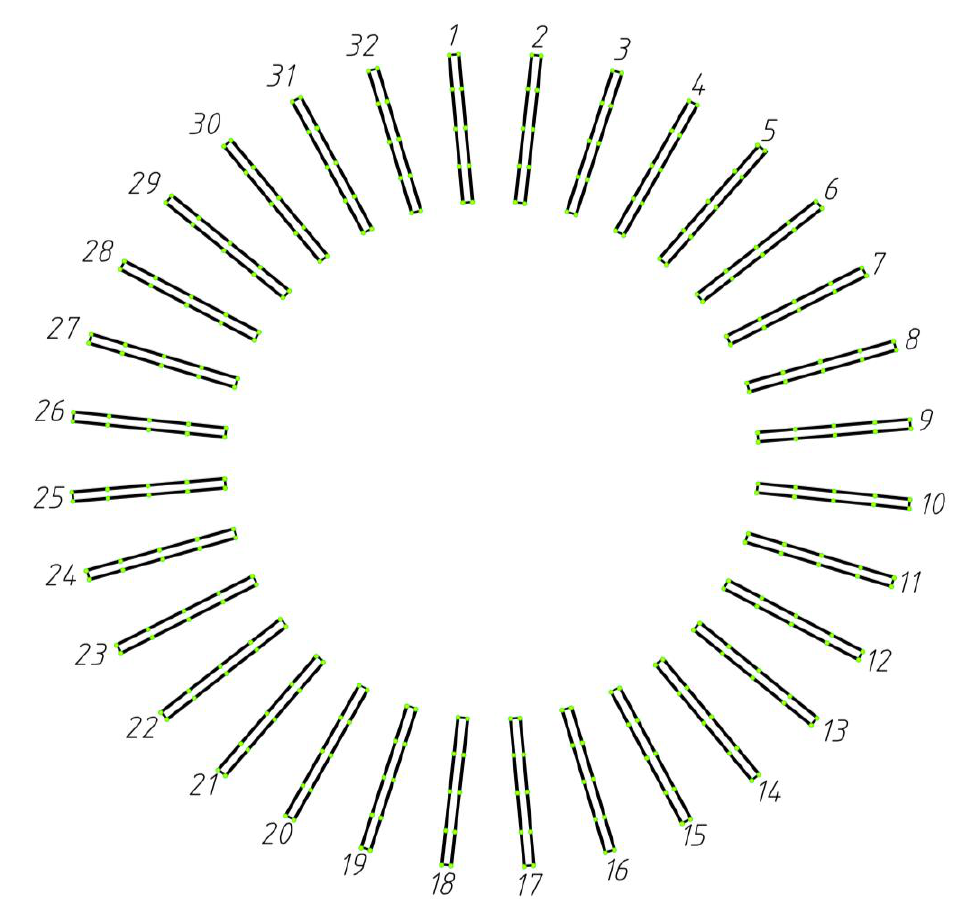
Figure 6. Simulation diagram of the fitted top surface of the tooth.